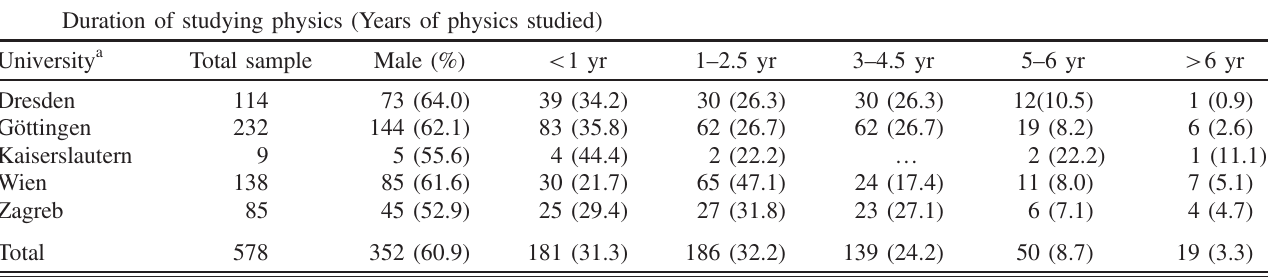
TABLE II. Information about the sample. Duration of studying physics (Years of physics